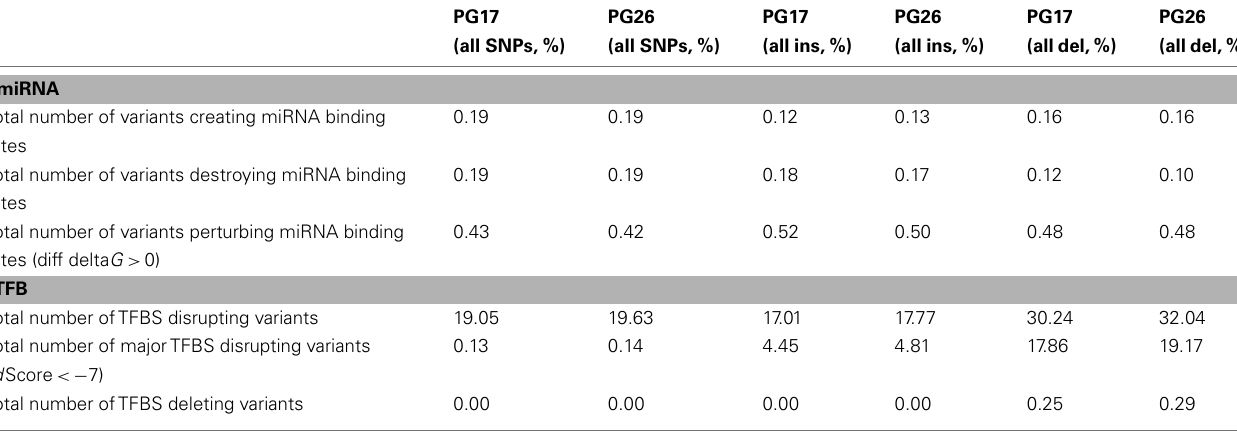
TableA6 | Rates of SNPs and indels that affect microRNAs and transcription factor binding sites